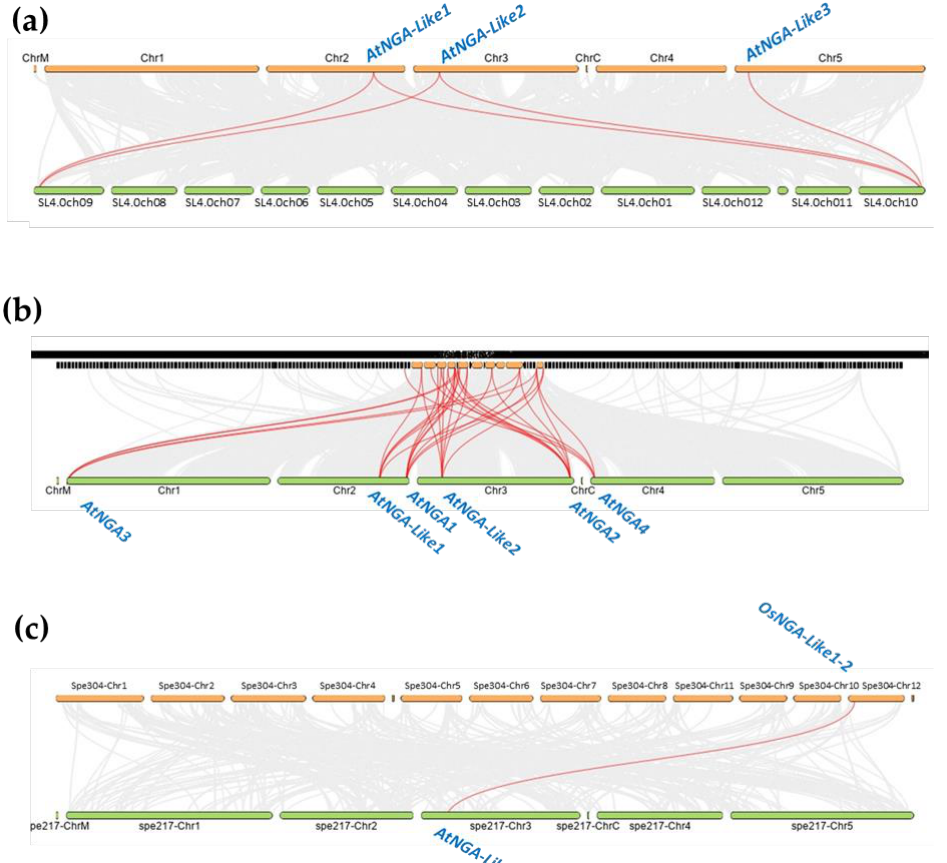
Figure 5. The gene duplication or synteny analysis of the NGATHA genes of A. thaliana with ( a ) S. lycopersicum ; ( b ) B. rapa, and ( c ) O. sativa L. Japonica. The grey lines (in the background) represent collinear blocks between the respective genomes. The red lines indicate the syntenic gene pairs of S. lycopersicum , B. rapa , and O. sativa L. Japonica with A. thaliana .